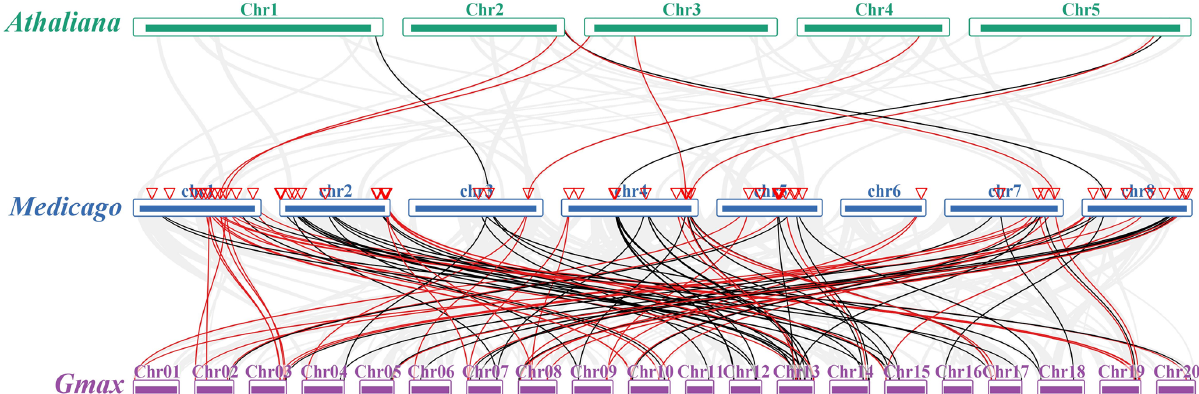
Figure 3. Synteny analysis of IAA and ARF genes in the genomes of Medicago truncatula , Arabidopsis thaliana and soybean. Green, blue and purple marks represent the Athaliana , Medicago and soybean chromosomes; the red and black marks represent MtIAAs and MtARFs , respectively.